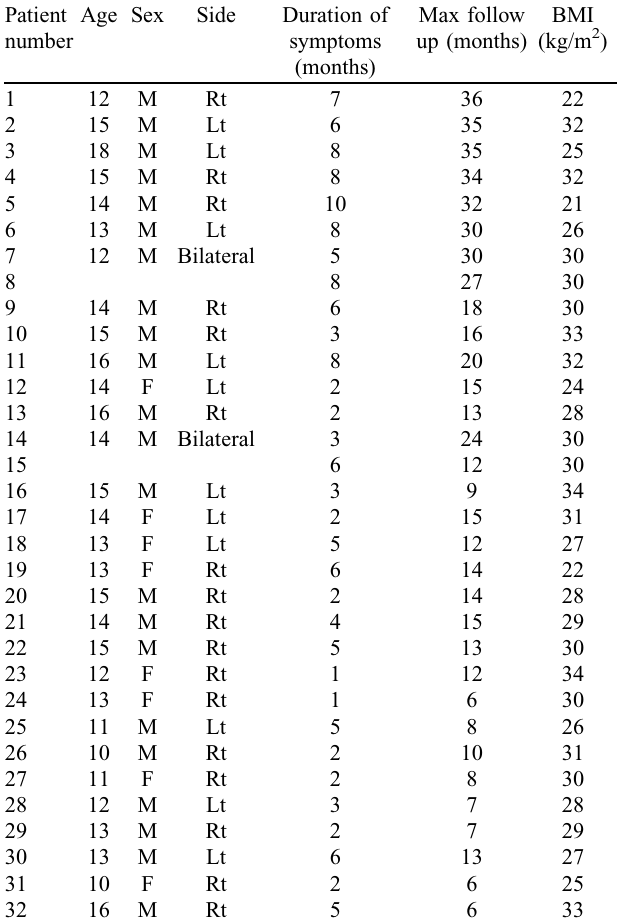
Table 1. Demographics and preoperative slipped capital femoral epiphyses (SCFE)